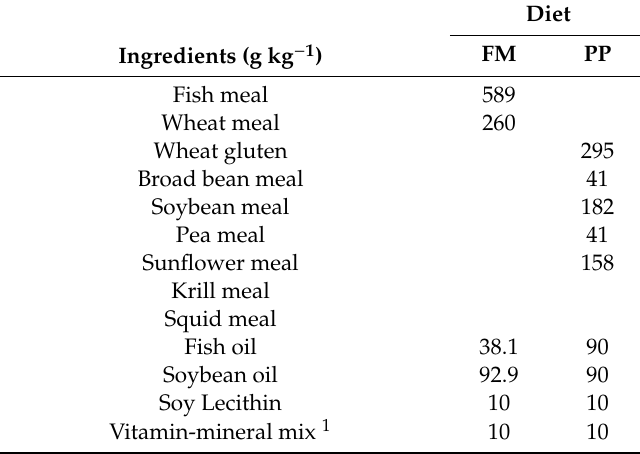
Table 2. Ingredients (g kg − 1 as fed) and proximate composition (% dry weight) of the experimental diets